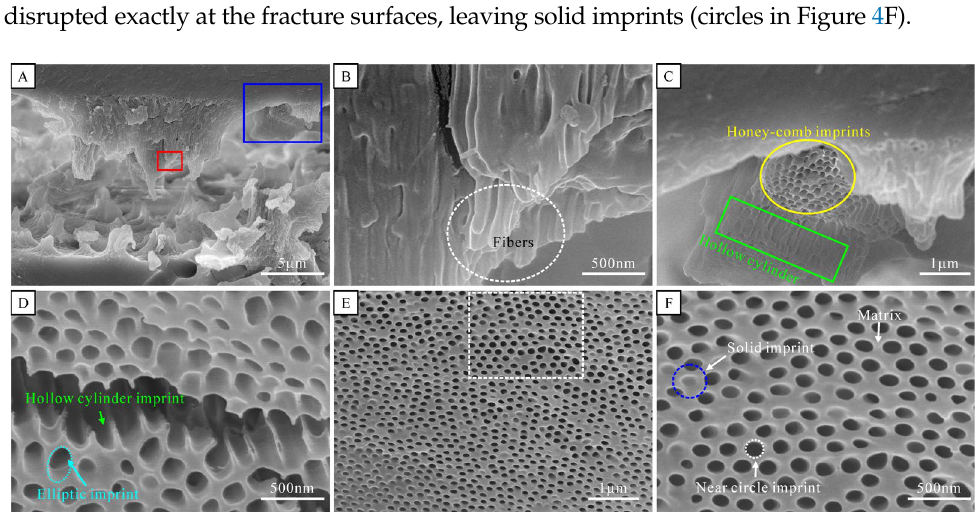
Figure 4. ( A – C ) SEM images of the damaged periostracum in cross-section fractured along the line a-a’ in Figure 1A. ( A ) Overview ( B , C ) the magnified image of the red box and the blue box in ( A ), respectively. ( D , E ) Sections fractured along the directions oblique or perpendicular to the fiber axes. ( F ) The magnified image of the white dashed box in ( E ).